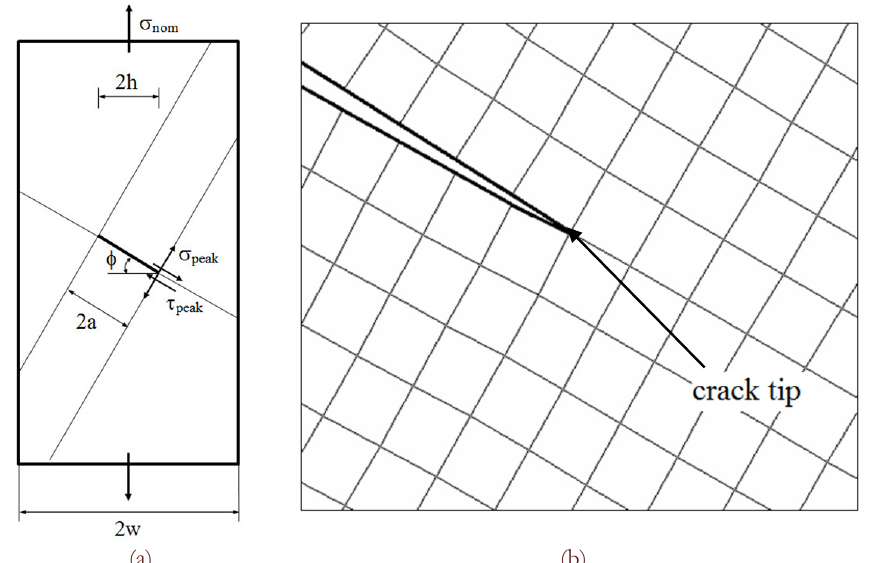
Figure 2: (a) Geometry and loading condition of the analysed mixed mode crack problem. 2W = 200 mm. (b) Pattern of finite elements around the singularity point: four elements share the node located at the crack